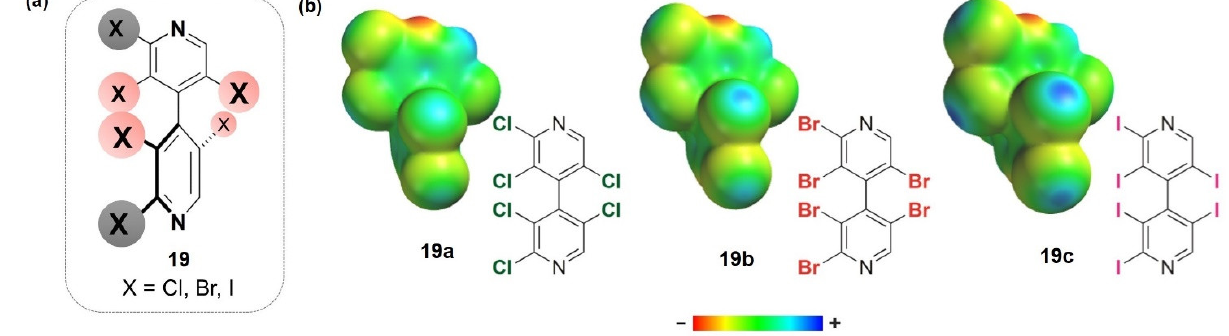
Figure 8. Halogenated 4,4′-bipyridines 19 ( a ), and V S representations on electron density isosurfaces (0.002 au) for representative compounds 19a – c ( b ). For the V S representations, colors toward red depict negative V S , while colors toward blue depict positive V S , and colors in between (orange, yellow, green) depict intermediate values.